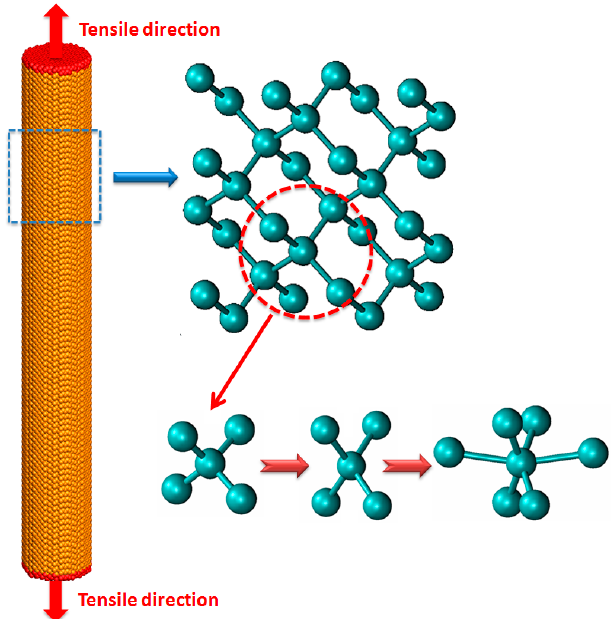
Figure 2. Microstructure of β -Sn phase.